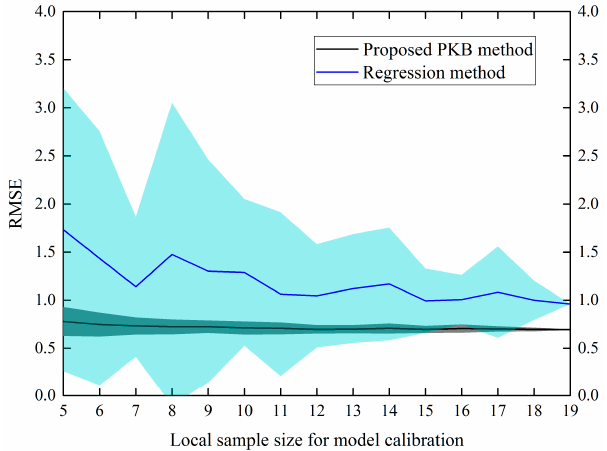
Figure 4. Accuracy (RMSE) of LAI estimates using PKB method and regression method. For each sample size, fifty replicates were randomly selected to construct the empirical model and then evaluated by the testing data. The gray area indicates the standard deviation of accuracy around the mean RMSE (black dash line) obtained by PKB method. The cyan area indicates the standard deviation of accuracy around the mean RMSE (blue solid line) obtained by regression method.